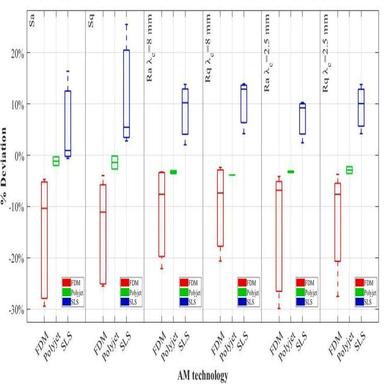
Average roughness % deviation comparison - AM Technology segmentation.